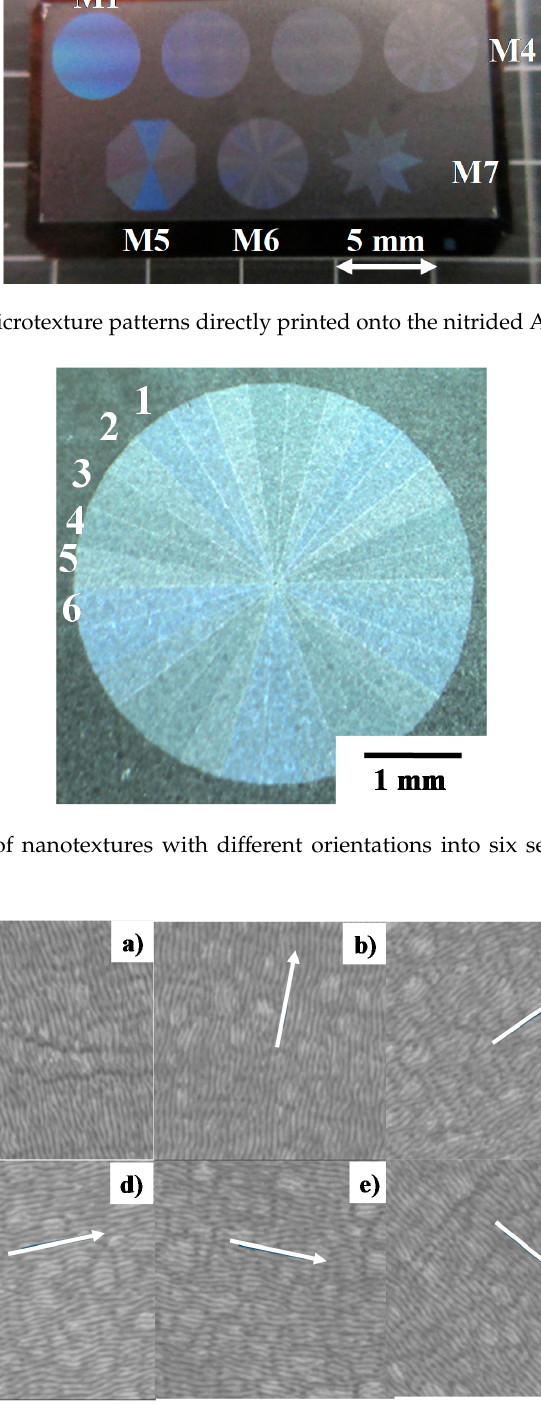
Figure 6. Nanotextures of six segments in M6 with a clockwise rotation of their orientations ( a – f ) in correspondence of #1 to #6 in Figure 5 by the femtosecond laser texturing.